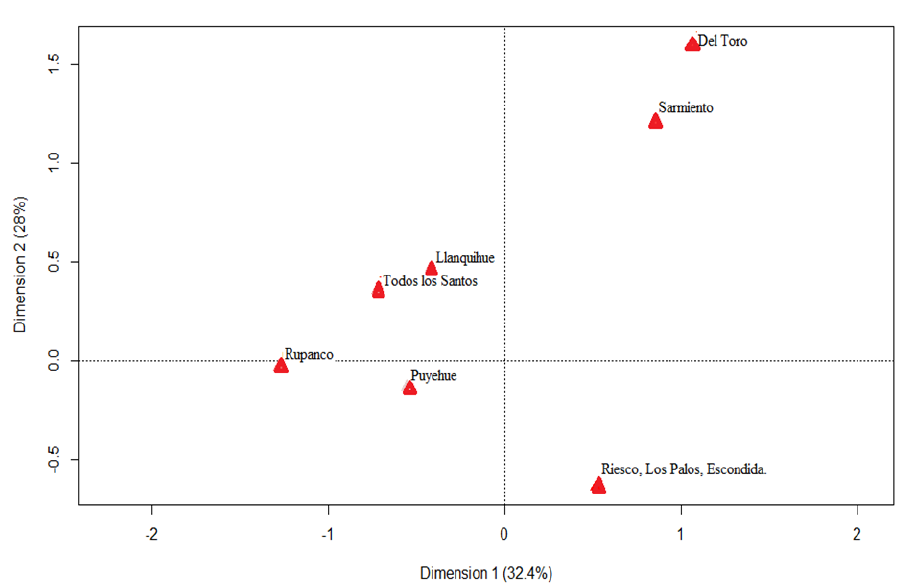
Figure 4. Results of correspondence analysis for sites in the presence-absence species